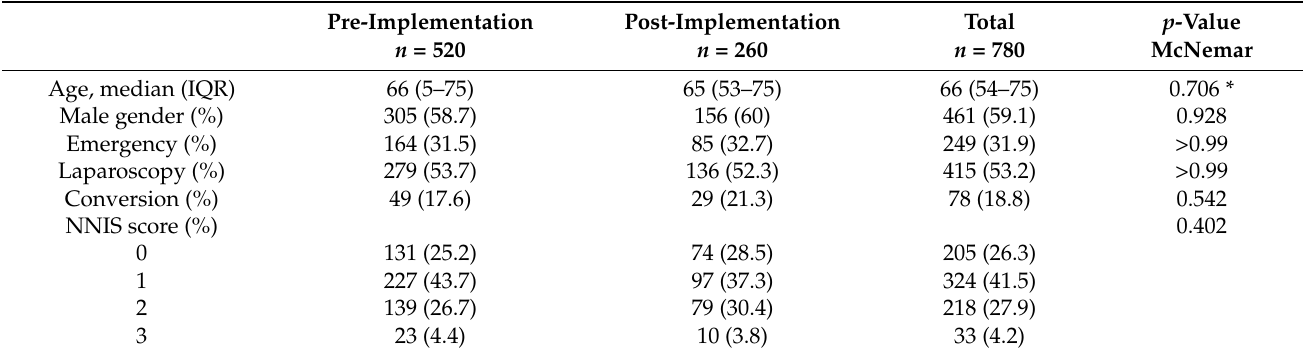
Table 2. Demographic characteristics and surgical details after